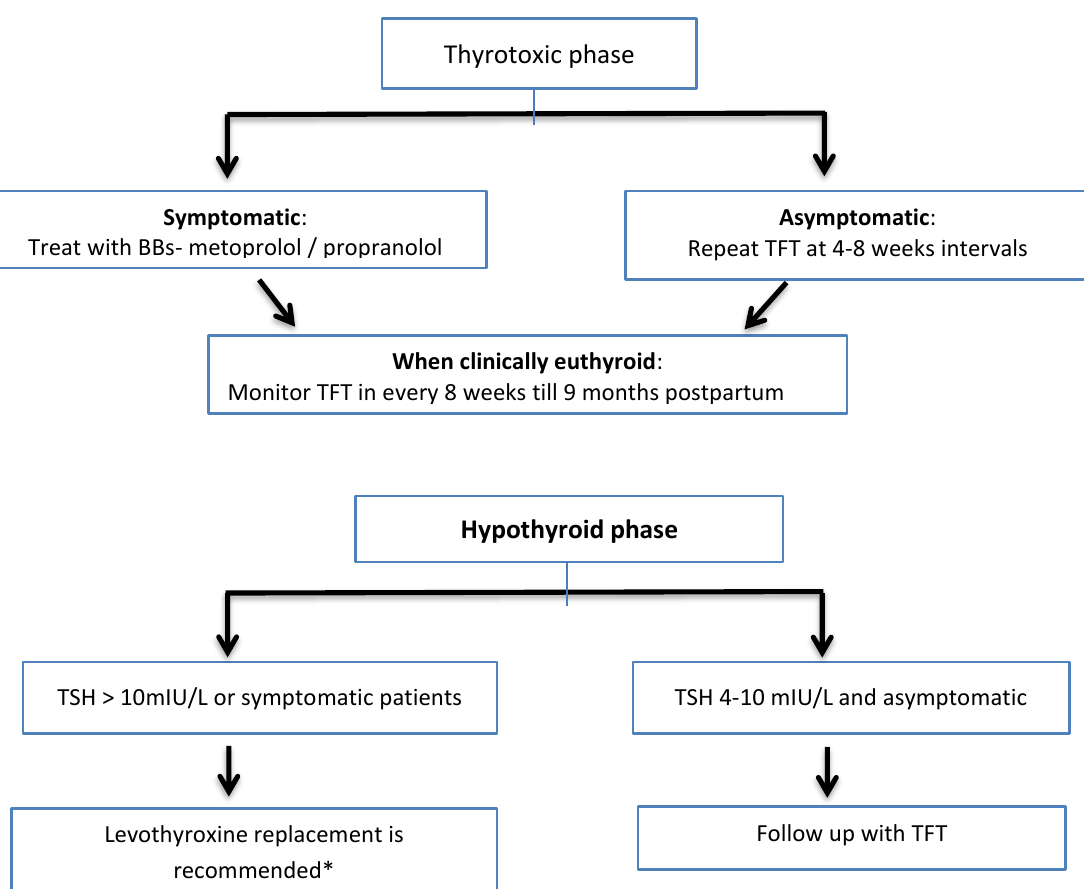
Figure 4.4. Management of different phases of post-partum thyroiditis *A decision to tail off levothyroxine may be considered if not planning to conceive by 1 year